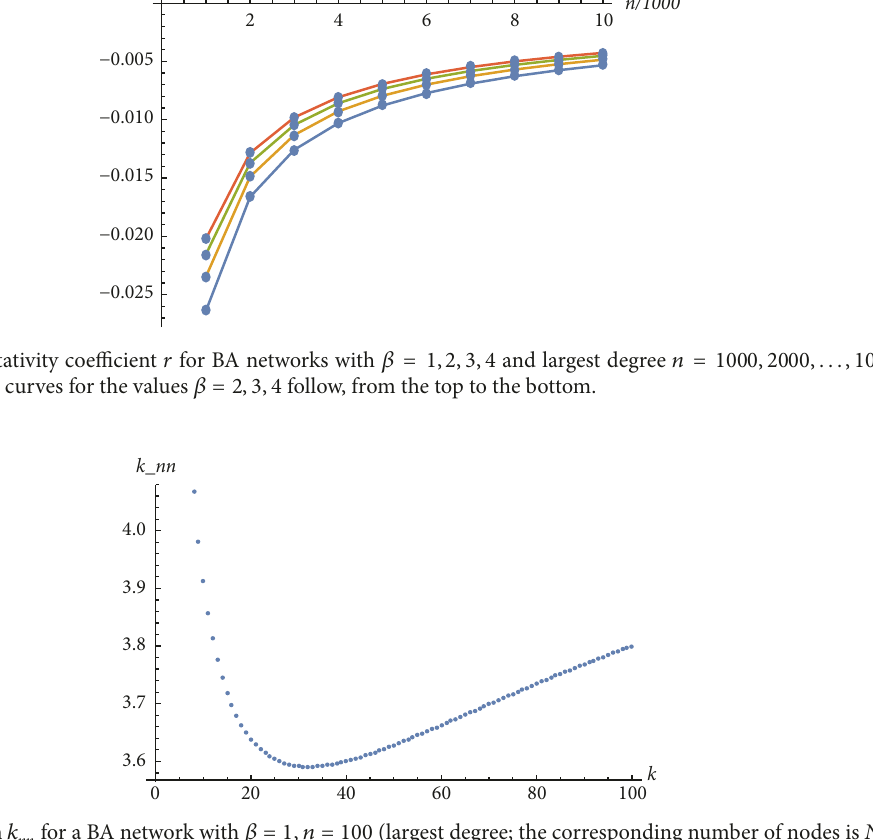
In [29] the expression (24) is then used to estimate 𝑘 𝑛𝑛 (𝑘)